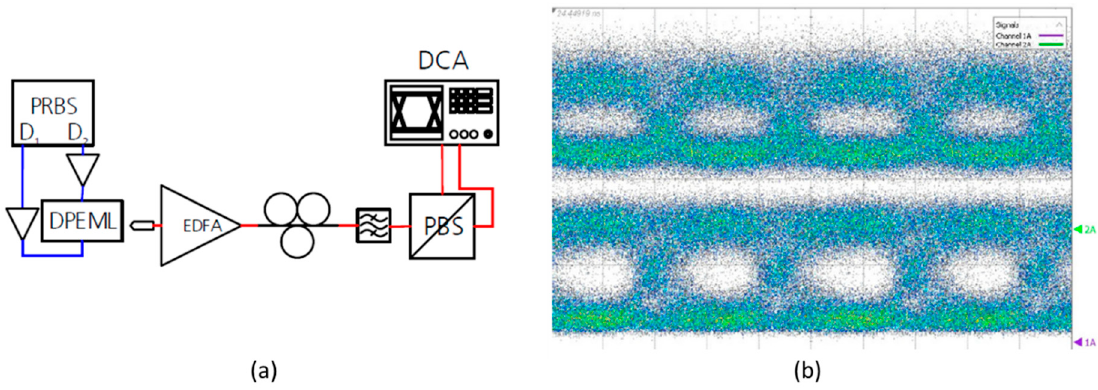
Figure 4. Schematic of the measurement setup used to characterize the DPEML ( a ), and eye diagrams of the TE- and TM polarized signal from the DPEML at 20Gb/s ( b ).